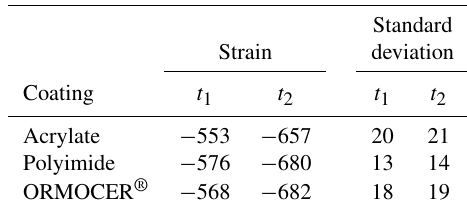
Table 6. Average strain values and standard deviation in the com- parison area at test times t 1 and t 2 (in µ ε ).